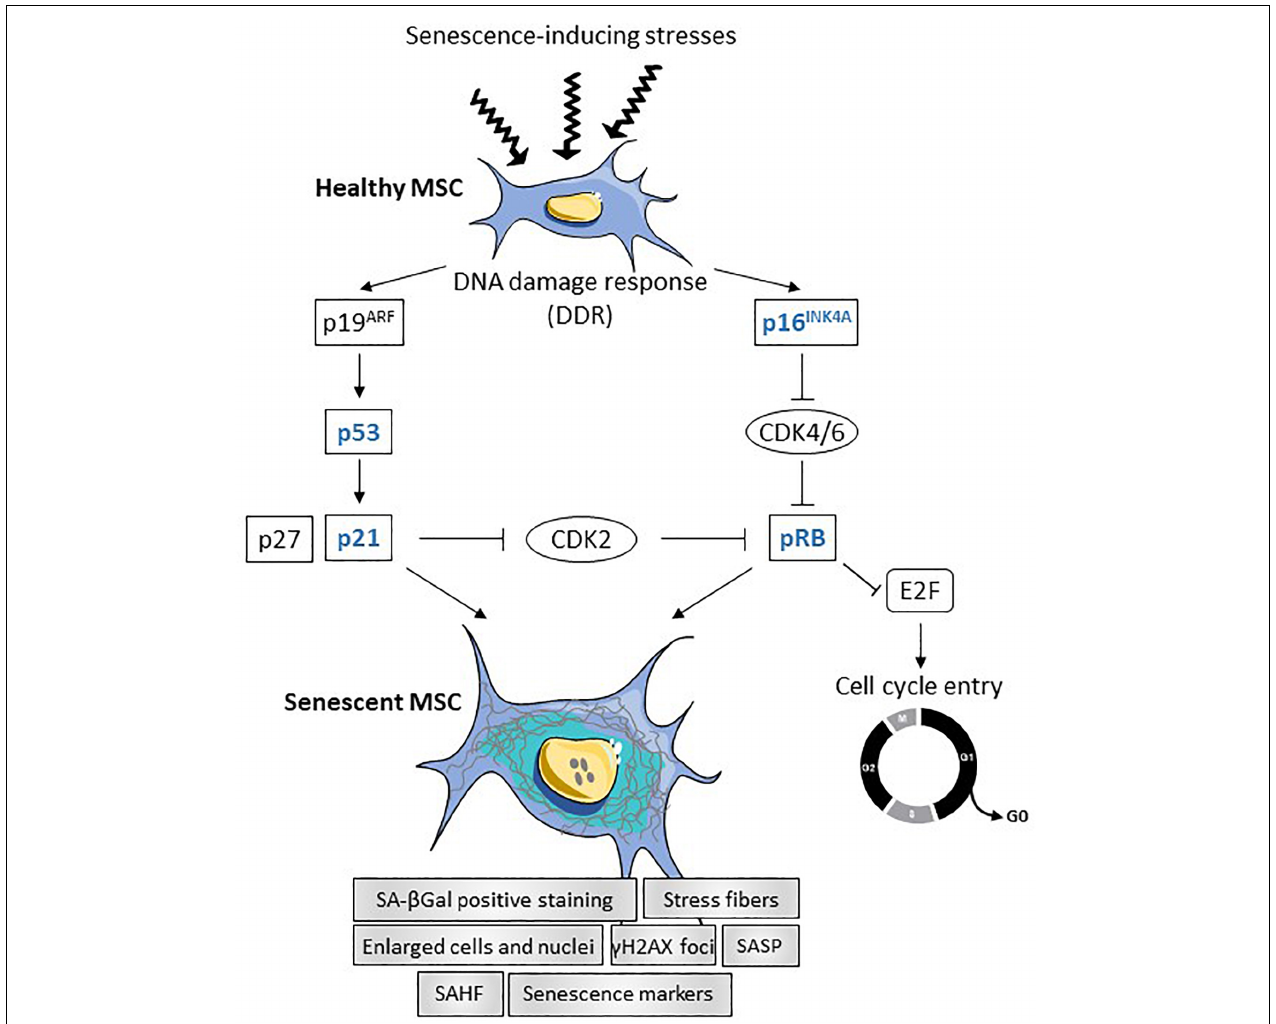
FIGURE 1 | Summary of transcriptional regulation of senescence in MSCs. In response to different stresses (oncogene, telomere attrition, oxydative stress, inflammation or mitochondrial dysfunction), DNA damage response (DDR) is induced in healthy MSCs leading to the activation of the two main signaling pathways p19 ARF and p16 INK 4 A . Activation of p19 ARF results in p53 and p21 activation, which inhibits CDK2 and induces senescence. Activation of the p16 INK 4 A -pRB pathway leads to cell cycle arrest and triggers senescence. Senescent MSCs are characterized by enlarged cells and nuclei, increased number of stress fibers, increased number of γ H2AX foci and senescence-associated heterochromatin foci (SAHF), positive staining for SA- β Gal and increased senescence markers and senescence-associated secretory phenotype